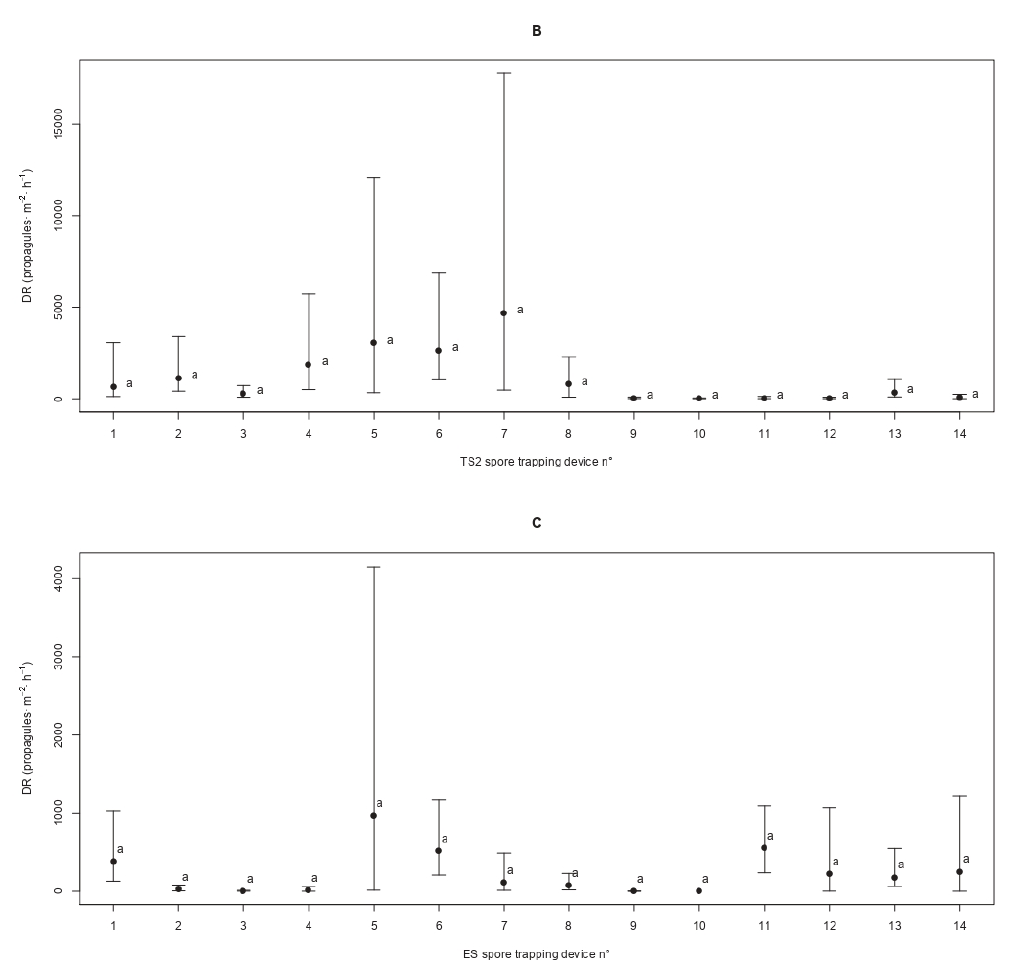
Figure 5. Patterns of the spatial propagule deposition of Cryphonectria parasitica . For sites TS1 (panel A ), TS2 (panel B ), and ES (panel C ), the mean deposition rate (DR) of the fungal pathogen and the 95% confidence interval are displayed for the different spore traps labelled from 1 to 14 as dots and t-shaped lines, respectively. Different letters are used to highlight significant differences ( p < 0.05) among average DRs depending on the spore trap locations along the linear transect.